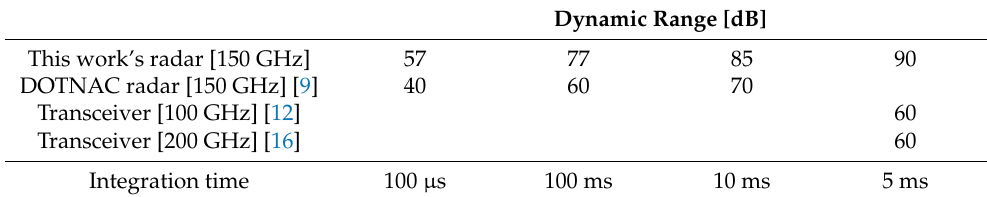
Table 2. Dynamic range for different acquisition times, with different FMCW